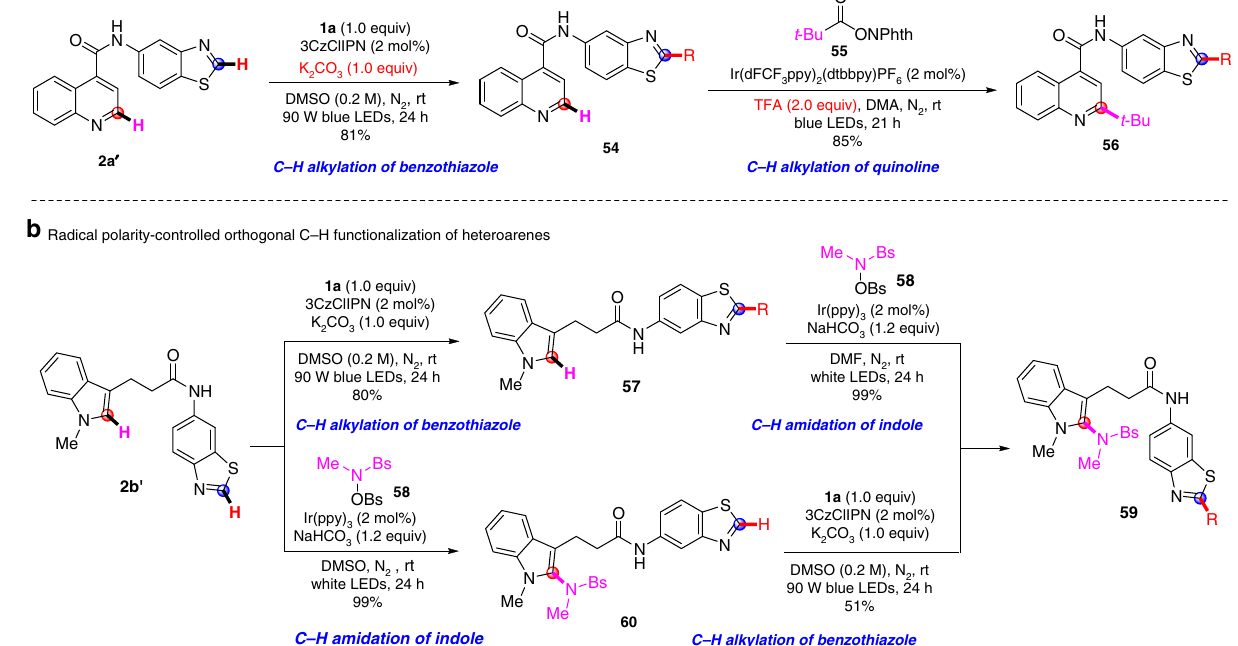
Fig. 5 Sequential and orthogonal C – H functionalization of heteroarenes. a pH-controlled orthogonal C – H functionalization of heteroarenes. b Radical polarity-controlled orthogonal C – H functionalization of heteroarenes. The structure of the R group is shown in Fig.